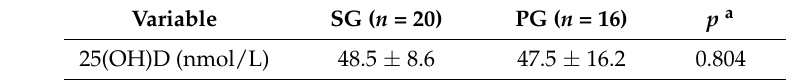
Table 1. Baseline parameters in the supplemented (SG) and non-supplemented (PG) groups.